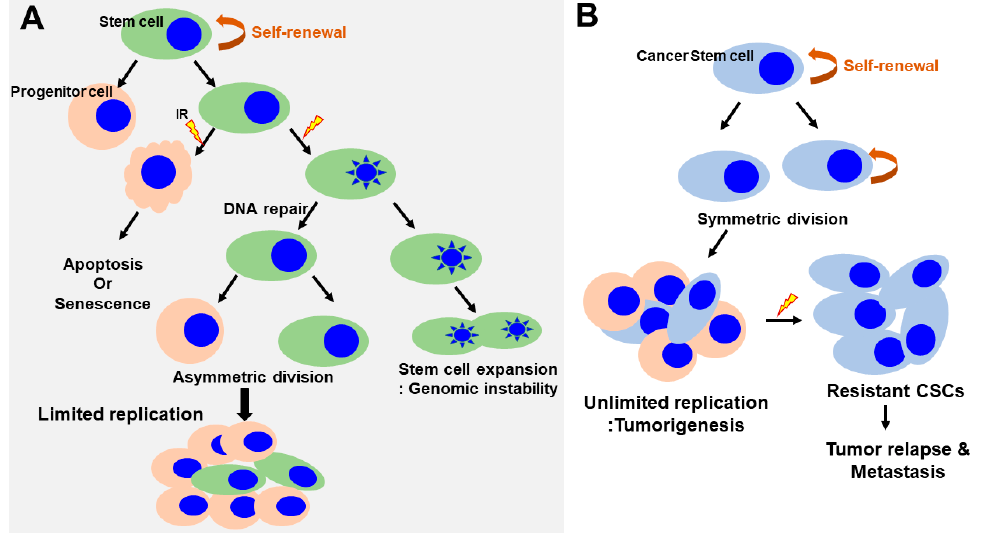
Figure 3. Regulation of self-renewal and DNA-damage response in normal and cancer stem cells. ( A ) Normal SCs asymmetrically divide, giving rise to stem cells and progenitor cells.